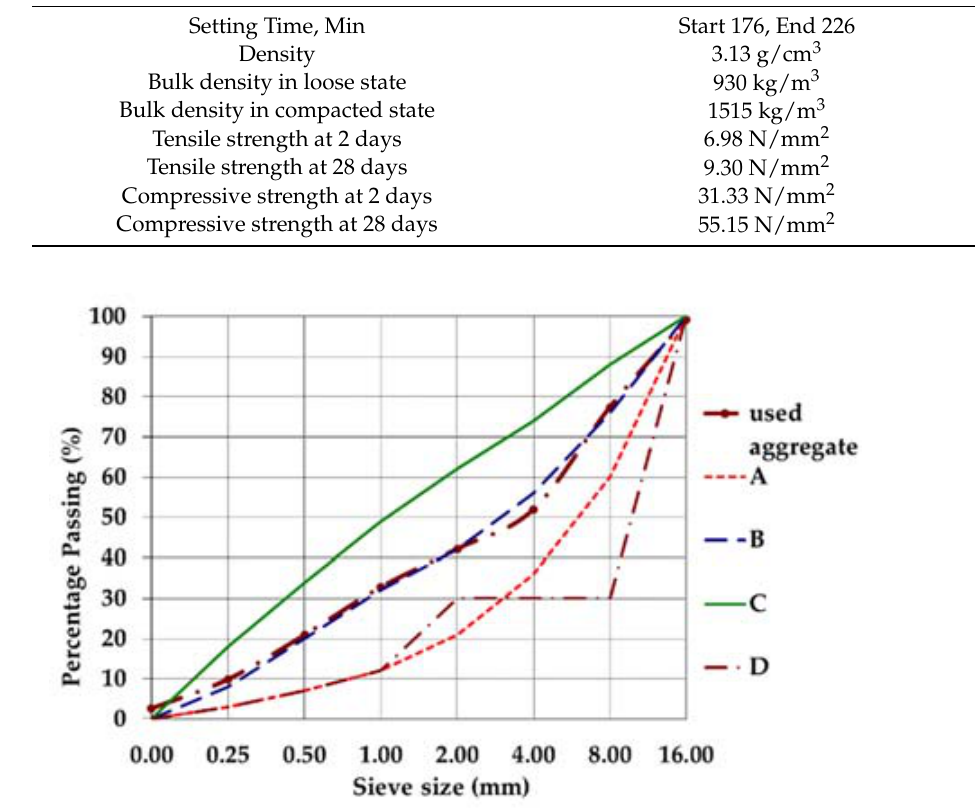
Figure 2. Particle size distribution of aggregates.